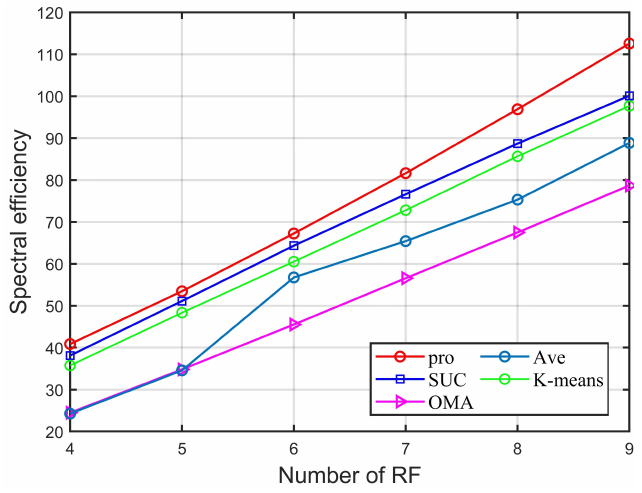
Figure 5. SE versus the number of the RF chains of different